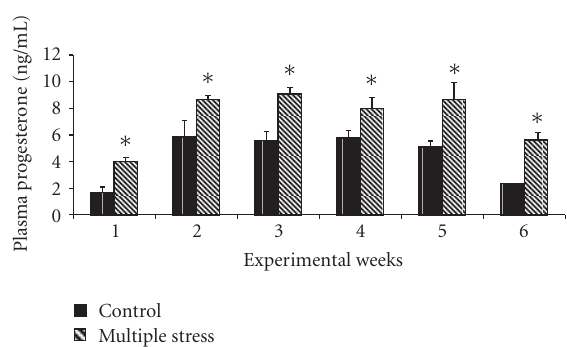
Figure 2: E ff ect of multiple stresses (thermal, nutritional, and walking stress) on the plasma progesterone levels in Malpura ewes. ∗ Indicates statistical significance to the respective control values at P < 0 .